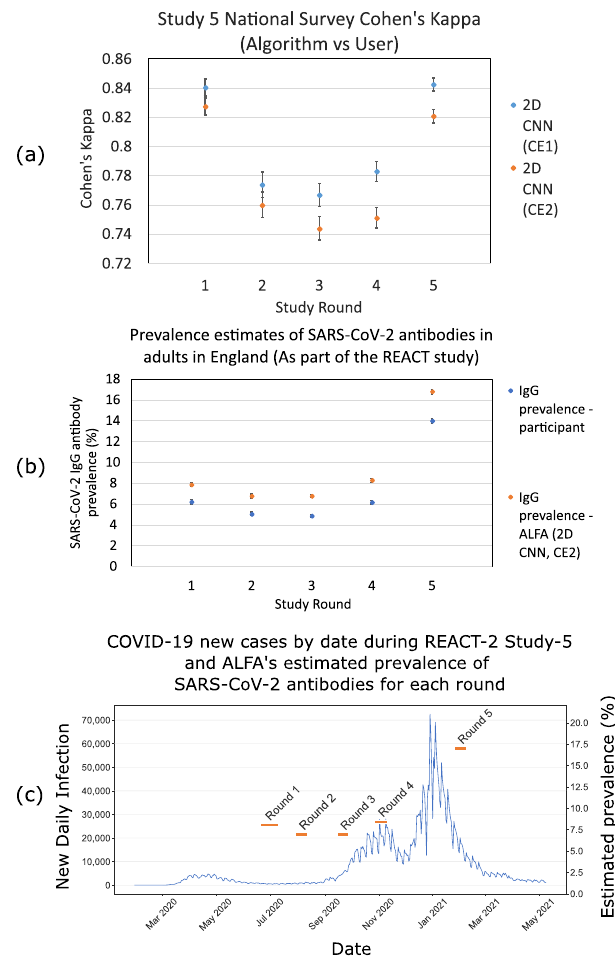
Fig. 3 Comparison between automated lateral fl ow analysis (ALFA) pipeline and REACT-2 Study-5 participants. a Cohen ’ s kappa between the two 2D Convolutional Neural Network (CNN) algorithms developed as part of the ALFA pipeline and study participants for REACT-2 rounds 1 to 5 (Respectively for each round, N = 93252, N = 95508, N = 123614, N = 133225, N = 140240). 2D CNN (Classi fi cation Experiment 2 (CE2), Blue) and 2D CNN (Classi fi cation Experiment 1 (CE1), Orange) indicate strong Cohen ’ s kappa, suggesting that participants are very good at reading their own results throughout the series of surveys. 2D CNN (CE1) is likely to have higher agreement than 2D CNN (CE2) because CE2 is picking up a greater proportion of weak positives, some of which are being missed by participants. The ALFA pipeline suggests substantial agreement between (0.70) participants ’ readings and the ALFA pipeline, providing con fi dence in the self-reading of fi ngerprick blood home self-testing LFIA kits. Error bars represent a 95% con fi dence interval. b Estimated prevalence of SARS-CoV-2 Immunoglobin G (IgG) antibodies in adults in England in the REACT-2 study by i) participant-reported results (Blue) and ii) ALFA (2D CNN CE2, Orange) automated read-out. Error bars represent 95% con fi dence interval, respectively for each round, N = 88557, N = 94291, N = 122211, N = 131327, N = 138200. c ALFA (2D CNN CE2, Orange bars) estimated antibody prevalence (Respectively for each round, N = 88557, N = 94291, N = 122211, N = 131327, N = 138200) overlaying daily new test positive COVID-19 cases (Blue line graph, Data acquired from GOV.UK here: